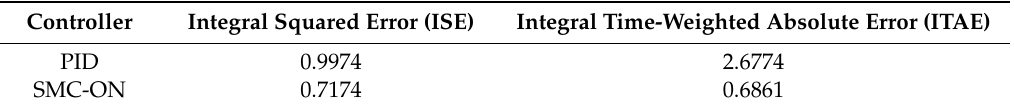
Table 1. Comparison of measured